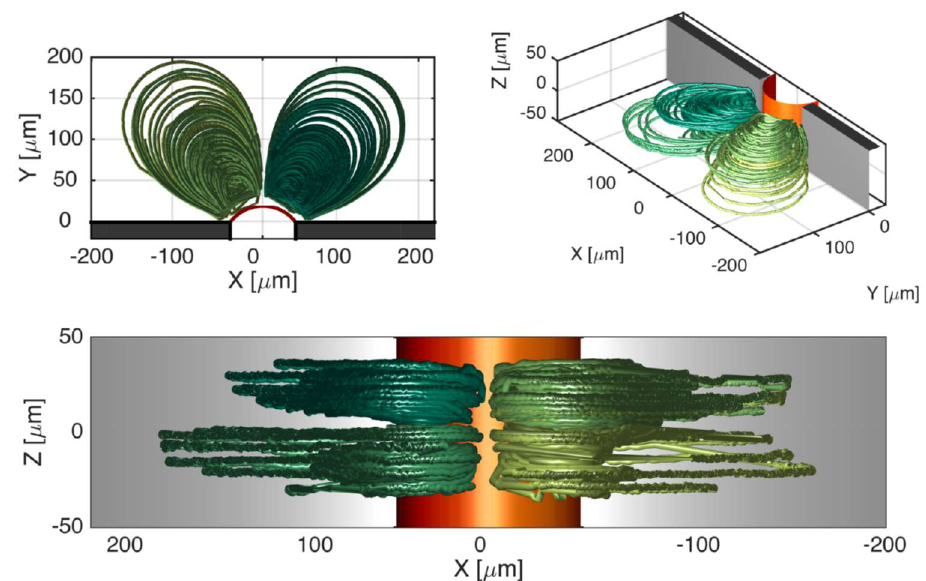
Figure 9. Three-dimensional trajectories of four different particles along different planes. Reproduced with permission from [45].